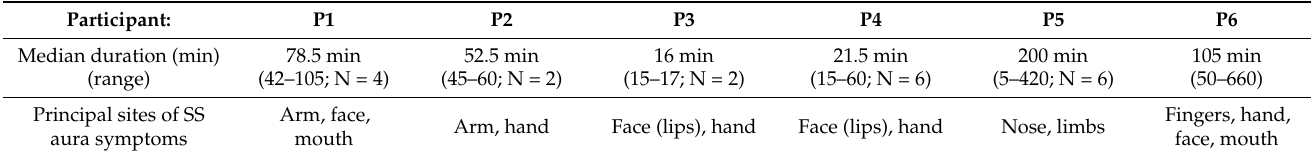
Table 4. Somatosensory Aura